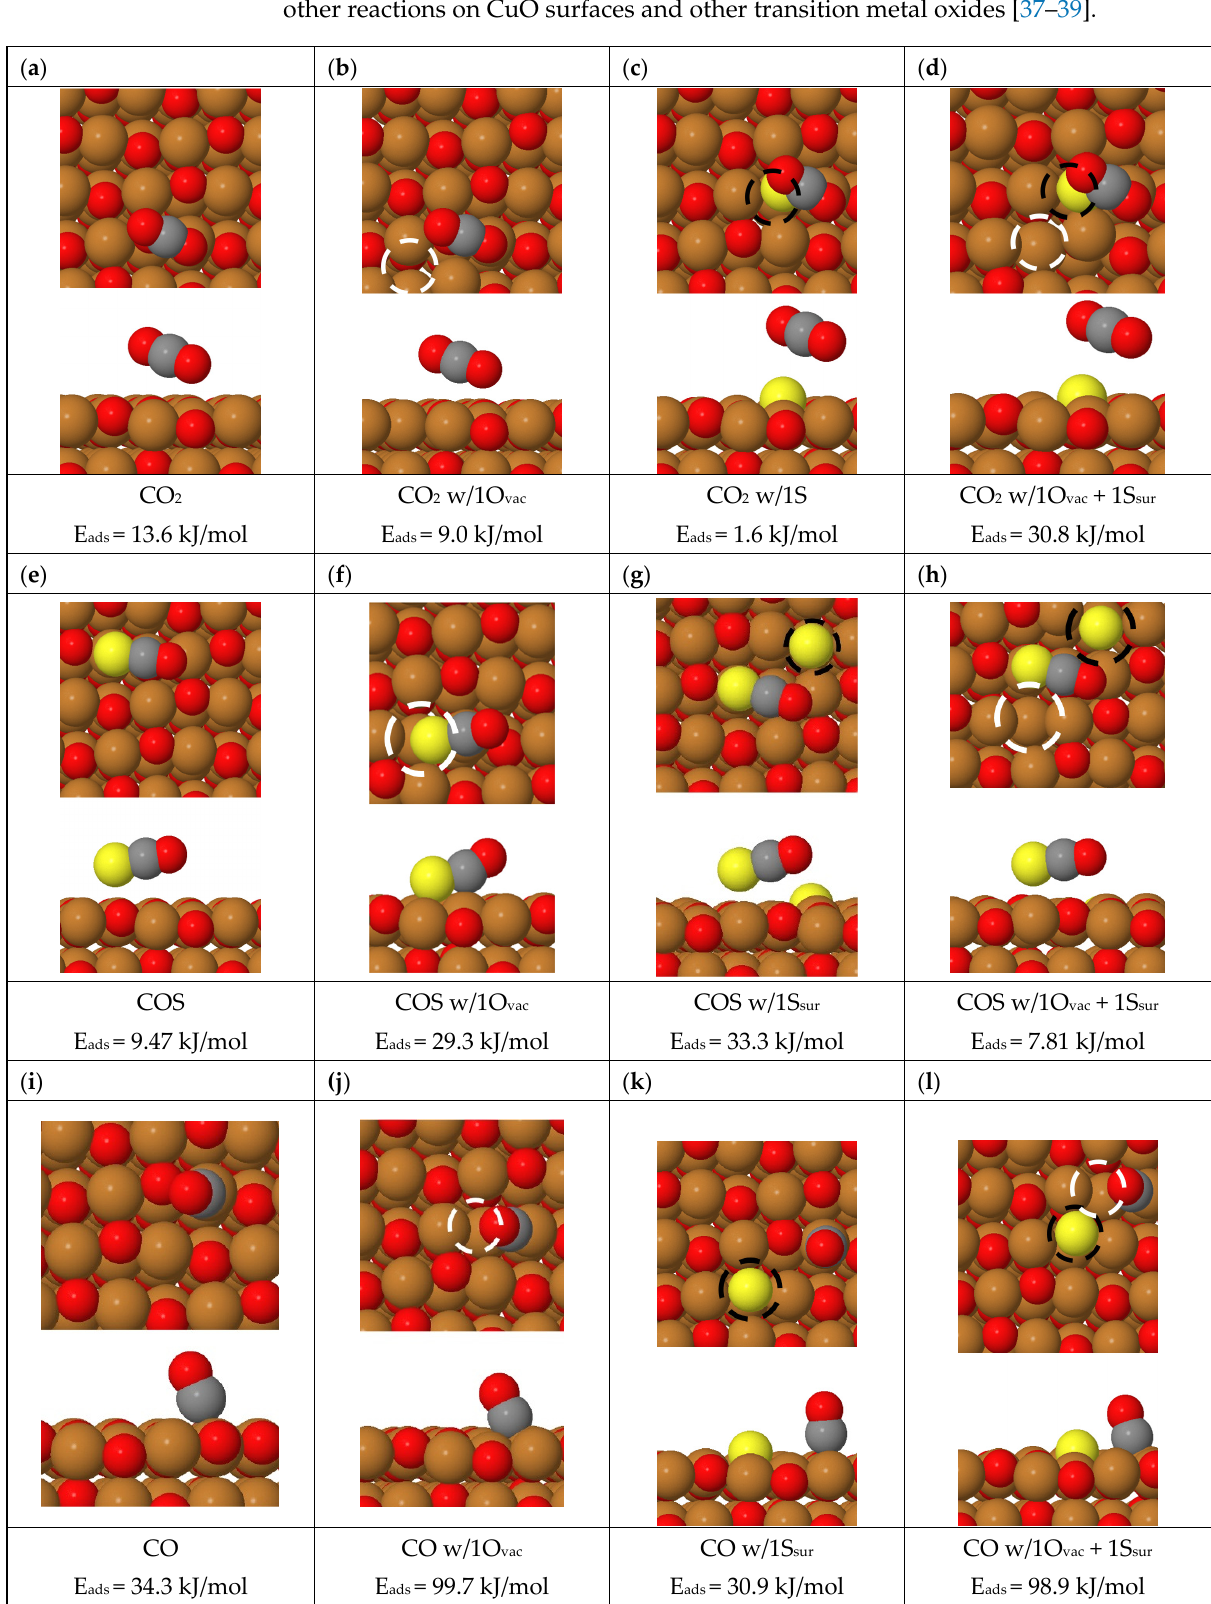
Figure 11. Top and side views of adsorbed CO 2 , COS, and CO on CuO(111) surface with and without an oxygen vacancy and a surface sulfur (yellow). The DFT predicted adsorption energy is presented below each figure.